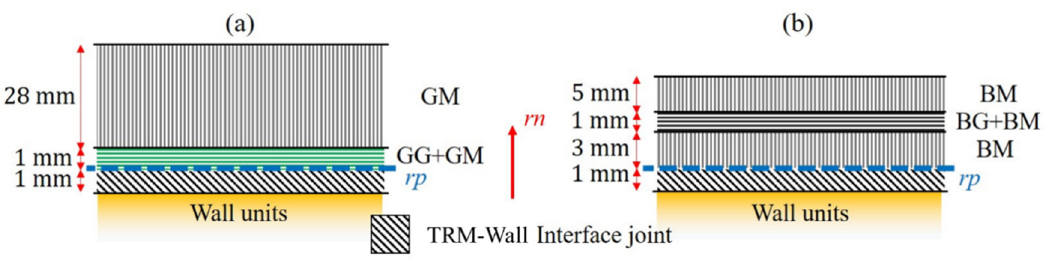
Figure 10. Assumed composite laminates: ( a ) glass-based TRM, ( b ) basalt-based TRM.